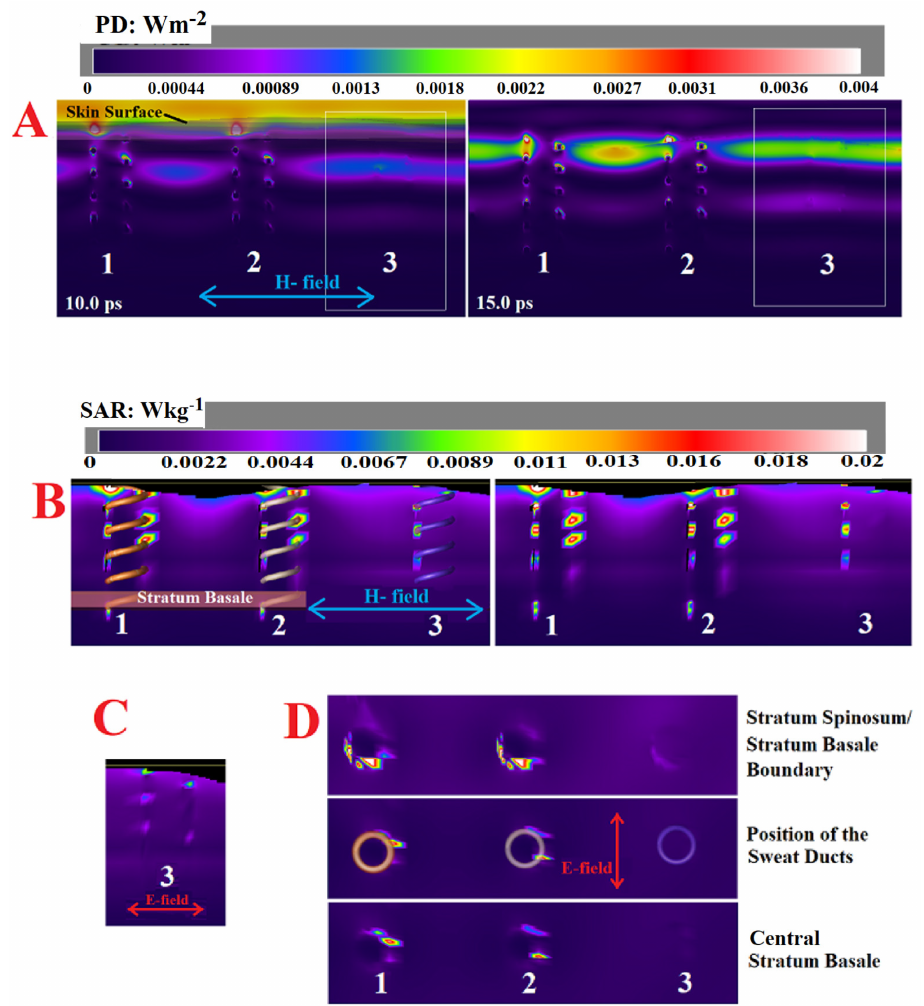
Figure 6. Simulations of PD and SAR surrounding sweat ducts in thick skin. The ducts (1) and (2) represent sweat ducts containing 10,014 Sm − 1 sweat, with an insulating layer surrounding the duct in (1). Duct (3) is filled with “physiological” sweat (105 Sm − 1 ). ( A ) Vertical section, direction of the polarized H-field as shown, PD at 10.0 and 15.0 ps into the simulation. There is little difference between the PD in the insulated and uninsulated ducts containing 10,014 Sm − 1 sweat. The duct containing the “physiological” sweat is barely discernable. ( B ) SAR, vertical cross-section, direction of the polarized H-field as shown. Left panel shows the general position of the sweat ducts and the Stratum Basale. The right edge of the duct containing the “physiological” sweat (105 Sm − 1 ) is barely discernable. ( C ) “Physiological” sweat containing duct, vertical section, the E-field as shown, polarization at 90 ◦ to the direction in ( B ). ( D ) Horizontal cross-sections at 0.0.35 mm depth (the level of the Stratum Spinosum/Stratum Basale boundary) and at 0.38 mm (within the Stratum